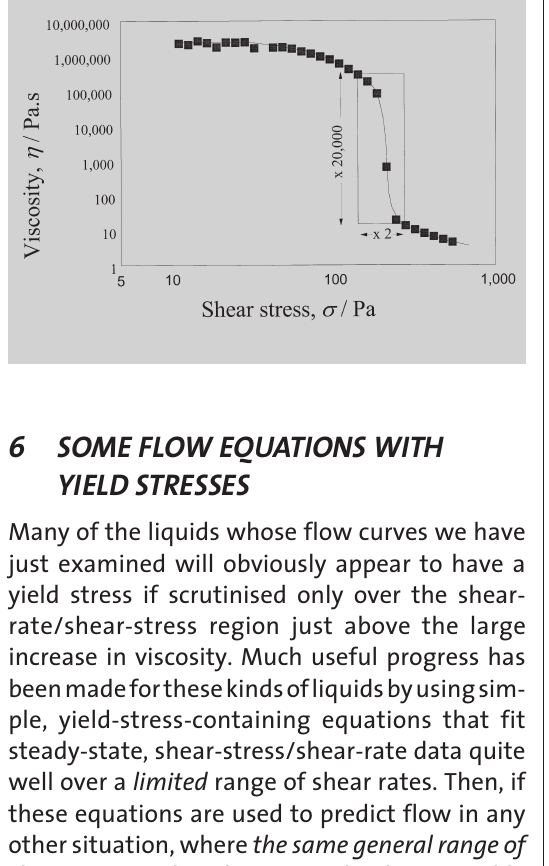
Figure 7 (left): Flow curve of a flocculated ink. Figure 8 (right): Flow curve of a